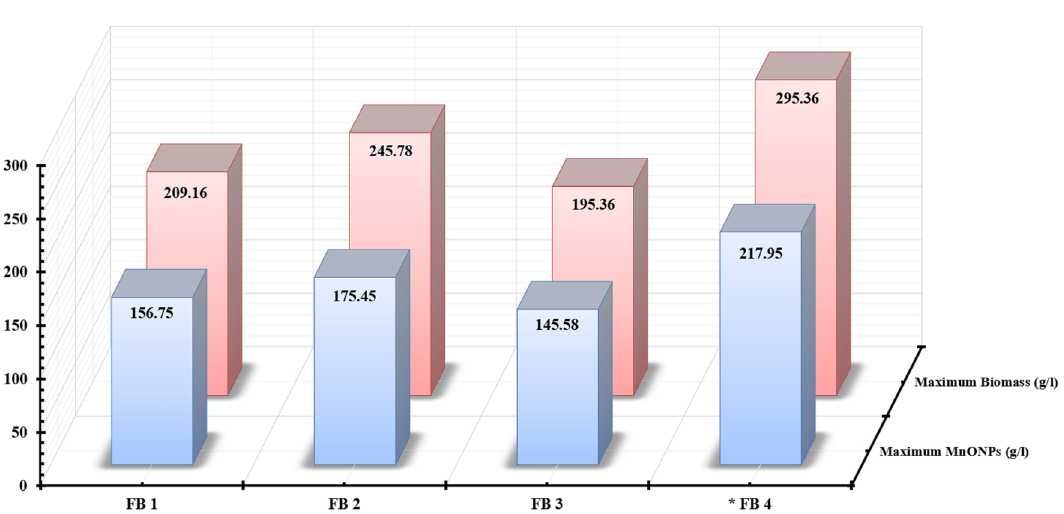
Figure 10. Study the effects of different fed-batch fermentation modes on the growth of endophytic T. virens strain EG92 hence the fabricated MnO NPs mass weight using submerged fermentation system via fed-batch mode within 7 L bioreactor. (FB1) constant feeding for whole medium, (FB2) Exponential pulses feeding for whole medium, (FB3) constant feeding for WBE, and (FB4) exponential pulses feeding for